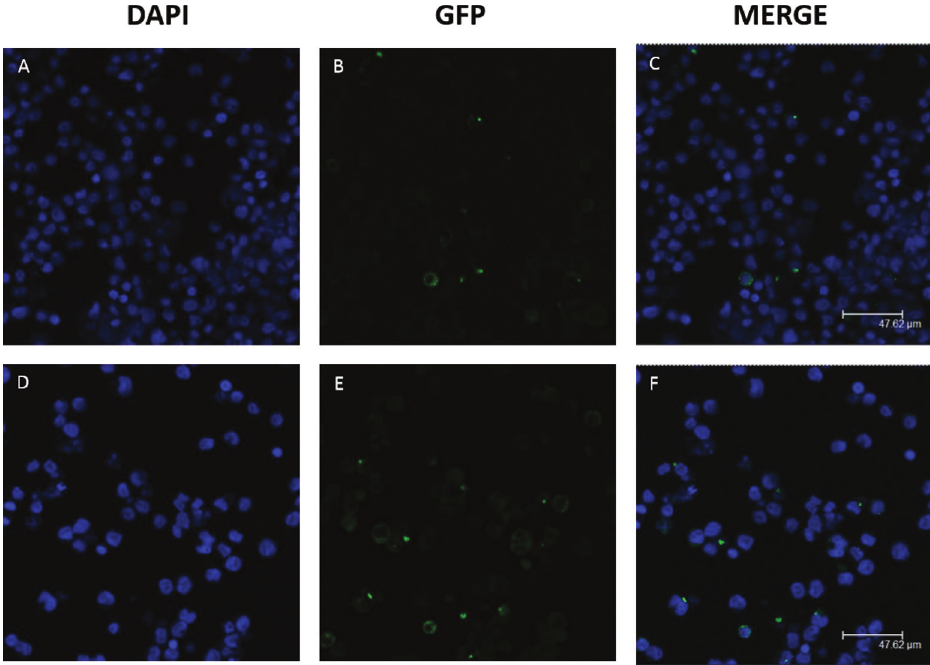
Figure 5 - Localization of recombinant MEFV proteins into neutrophil-like cells. 5 x 10 4 cells/mL were incubated with DMSO for 6 days. MEFV -fl-GFP and MEFV -d2-GFP constructs were transfected via Nucleofection and the localization of their products was analyzed using confocal microscopy. The transfectionefficiencywas50%for MEFV -fland72%for MEFV -2d.A)DAPIstainingofDMSOinducedHL-60celltransfectedwith MEFV- fl-GFP;B) GFP visualization of MEFV -fl-GFP; C) Merged image of A and B; D) DAPI staining of DMSO induced HL-60 cell transfected with MEFV -d2-GFP; E) GFP visualization of MEFV -d2-GFP; F) Merged image of D and E.